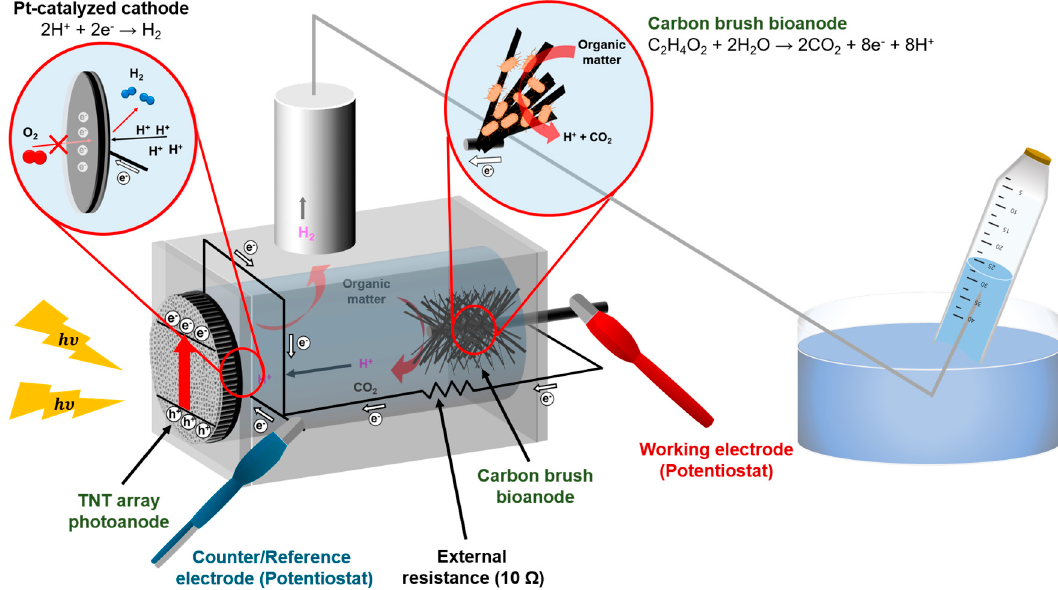
Figure 1. Schematic illustration of the hybrid microbial electrolysis cell (MEC) with external TiO 2 photoanode.